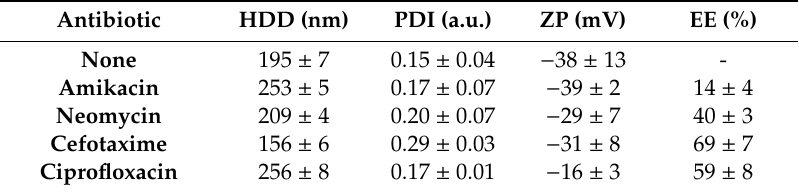
Physico-chemical characteristics and encapsulation e ffi ciency (EE) of PMVE / MA-Es Table 2. Physico ‐ chemical characteristics and encapsulation efficiency (EE) of PMVE/MA ‐ Es nanoparticles loaded with nanoparticles loaded with antibiotics.